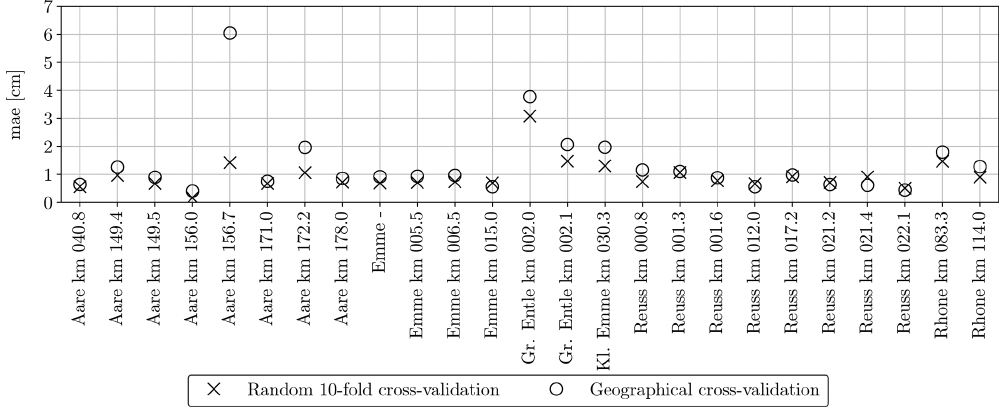
Figure 19. Mean absolute error of the GRAINet end-to-end d m regression per gravel bar (random and geographical